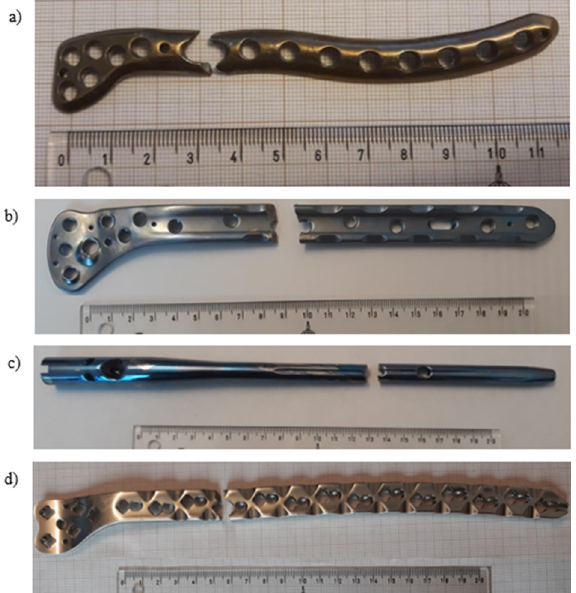
Figure 1. General view of the exploited implants with different geometries made of pure titanium clavicular ( a ) and distal femoral ( b ) plates, Ti-6Al-4V femoral gamma nail ( c ) and a X2CrNiMo18-14-3 femoral condylar plate ( d ).